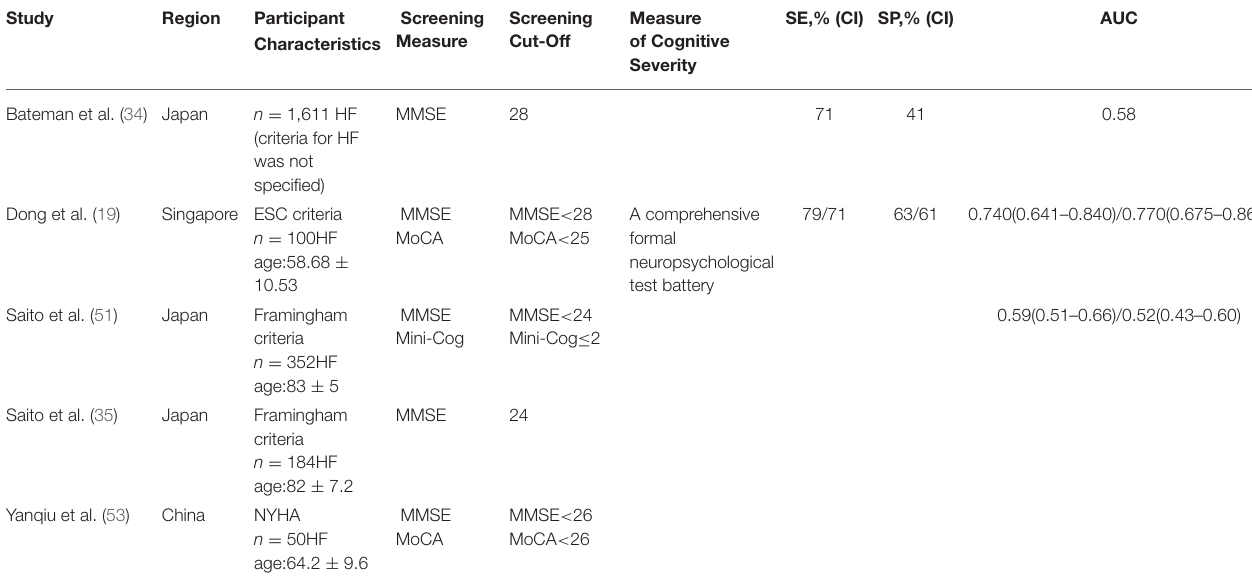
TABLE 1 | Comparison of cognitive screening instruments used in patients with heart